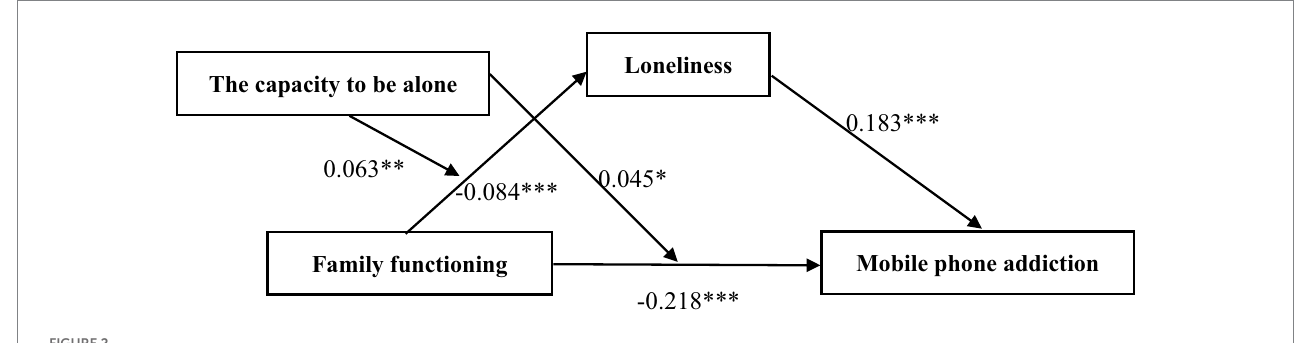
FIGURE 2 The path coefficients in the moderated mediation model. *** p < 0.001, ** p < 0.01, * p <